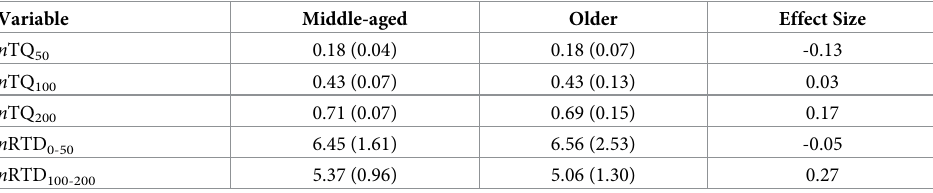
Table 2. Torque parameters normalized to peak torque for both